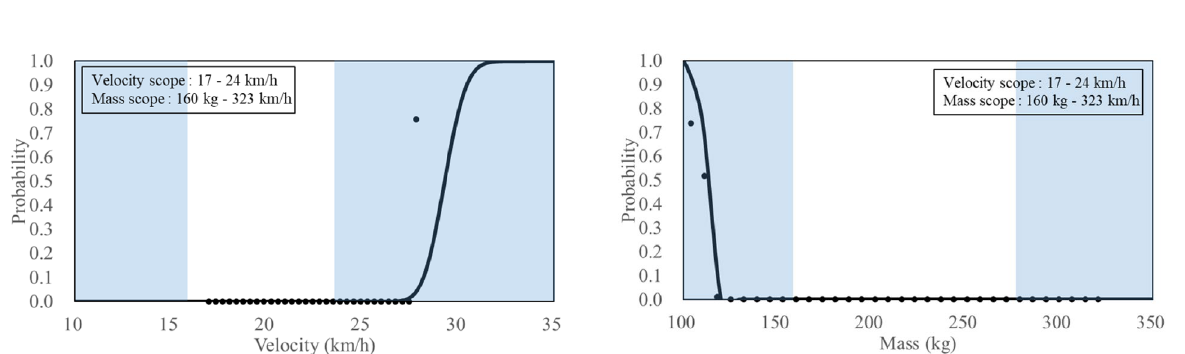
Figure 15. Presented fragility curves under same local impact energy 3.6 kJ (Travel